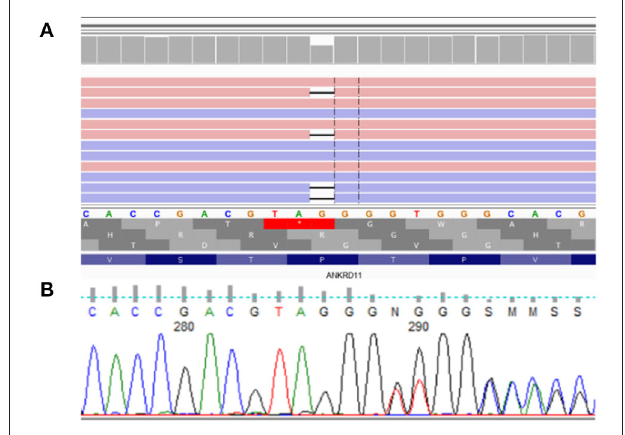
FIGURE 5 | De novo heterozygous frameshift variant NM_001256182.1:c.5117delC NP_001243111.1:p.Pro1706LeufsTer13 in exon 10 (of 14) of ANKRD11 . (A) presents analysis from NovaSeq sequencing platform, (B) confirmation of detected variant by Sanger sequencing.